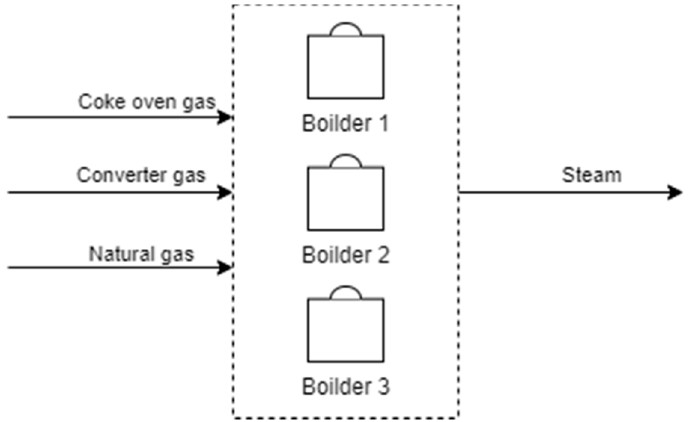
Figure 2. Schematic view of the thermal plant.